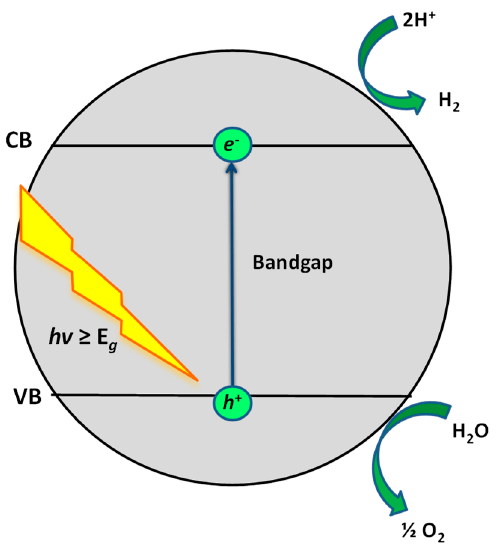
Figure 11. The principle photocatalytic water splitting mechanism over illuminated TiO 2 nanoparticle.